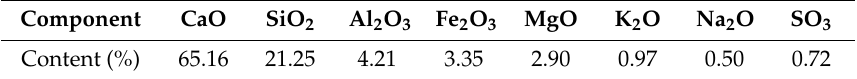
Table 1. Chemical composition of cement (% by weight).